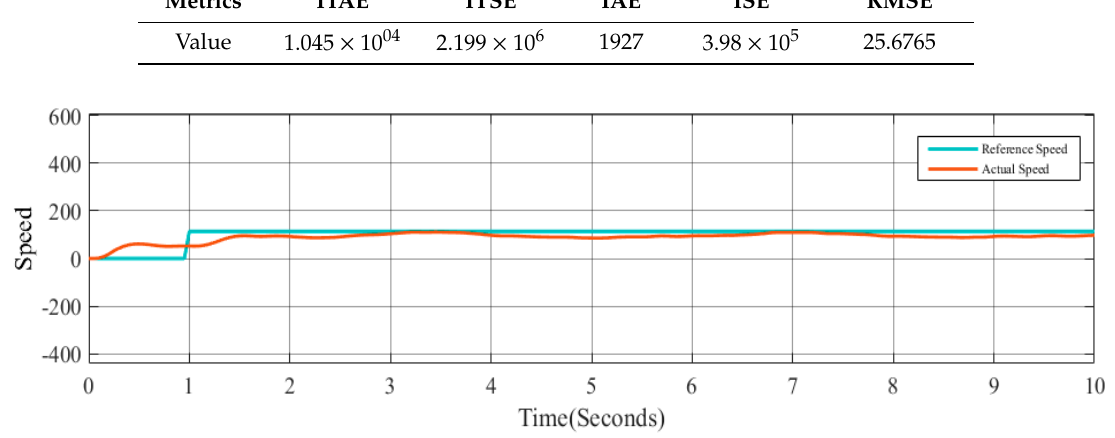
Figure 18. Simulation for FLC controller.